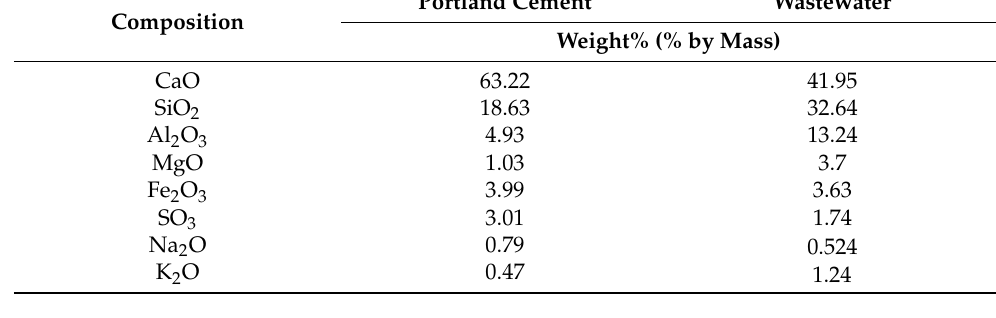
Figure 4. XRD analysis results of wastewater particles. Table 2. Chemical characteristics of wastewater and cement.